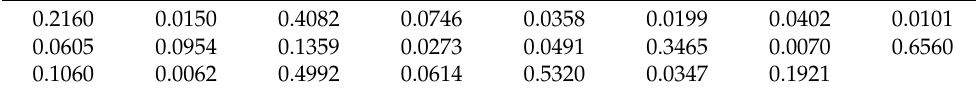
Table 10. Secondary reactor pumps